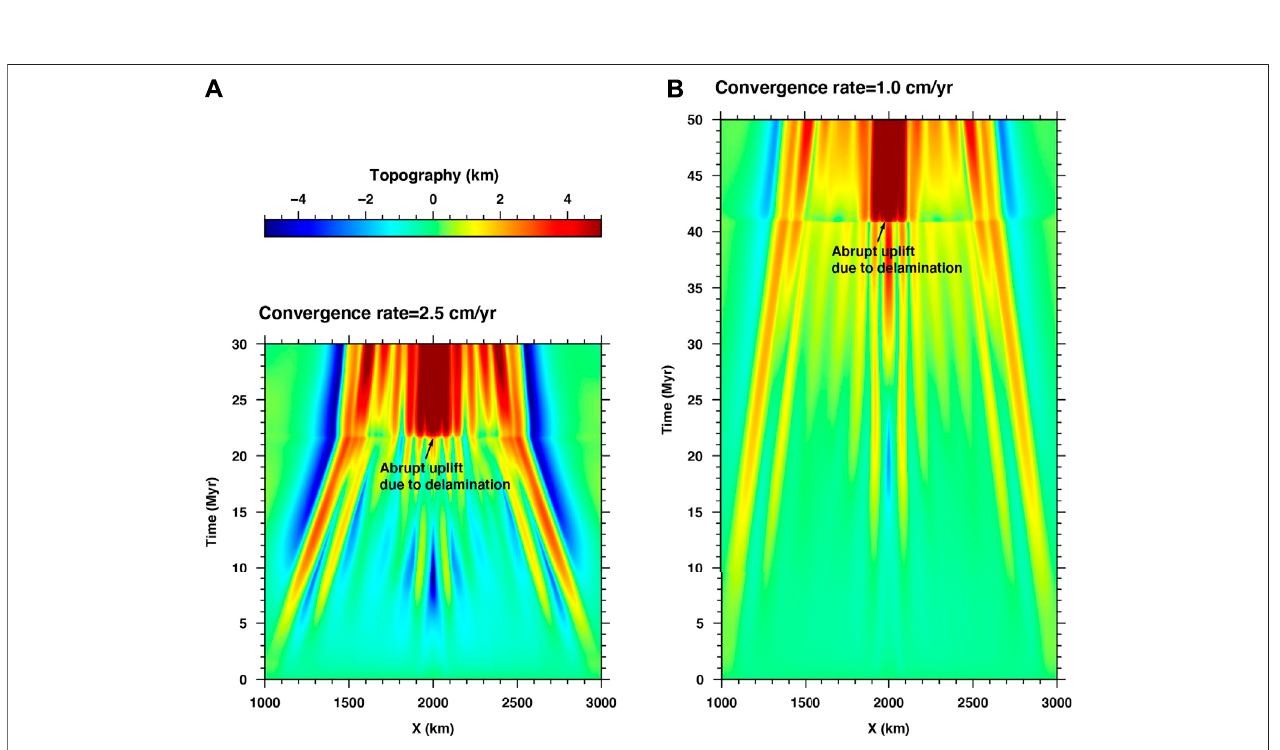
FIGURE 8 | Topography evolutions predicted by the fast convergence model “ delb ” B and slow convergence model “ delj ” (B) .